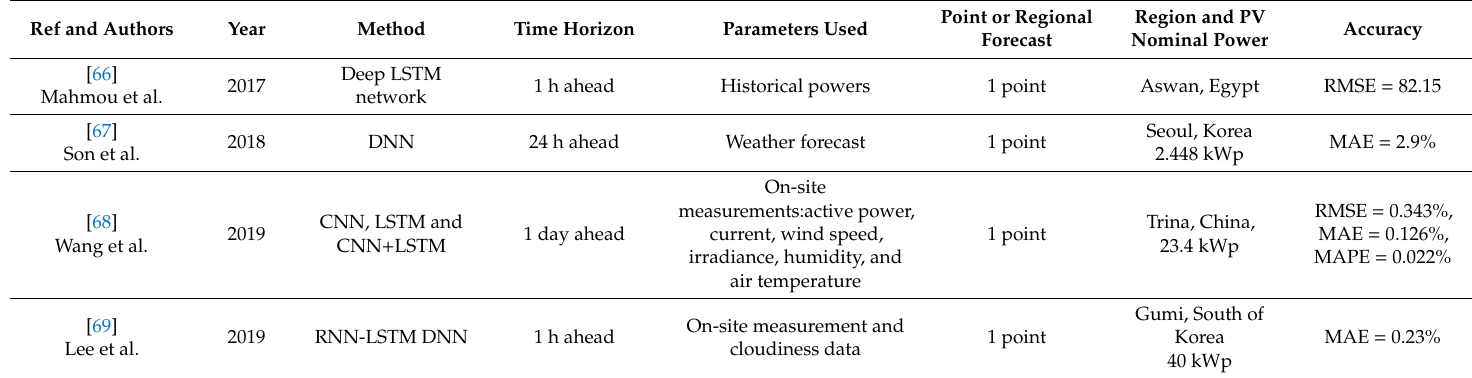
Table 3. DL-based methods for the forecast of PV power-period